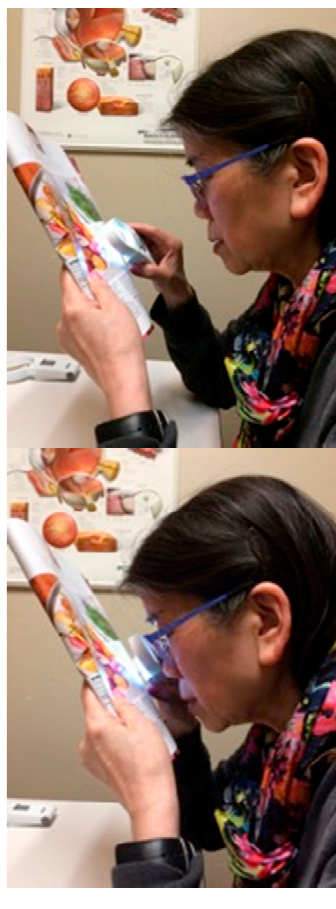
Figure 11. Handheld magnifiers.